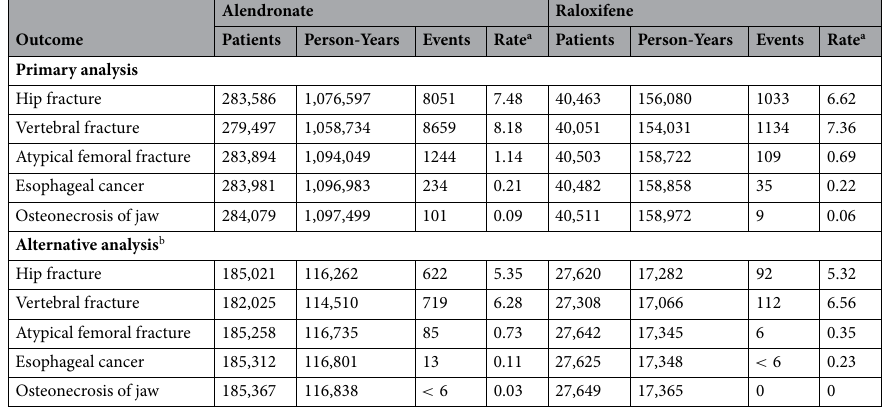
Table 1. Size of study cohorts for each outcome of interest in primary and alternative analyses. a Rate: incidence per 1,000 person-years. b Three data sources excluded from alternative analysis (P-Plus, NHIS NSC, Cerner